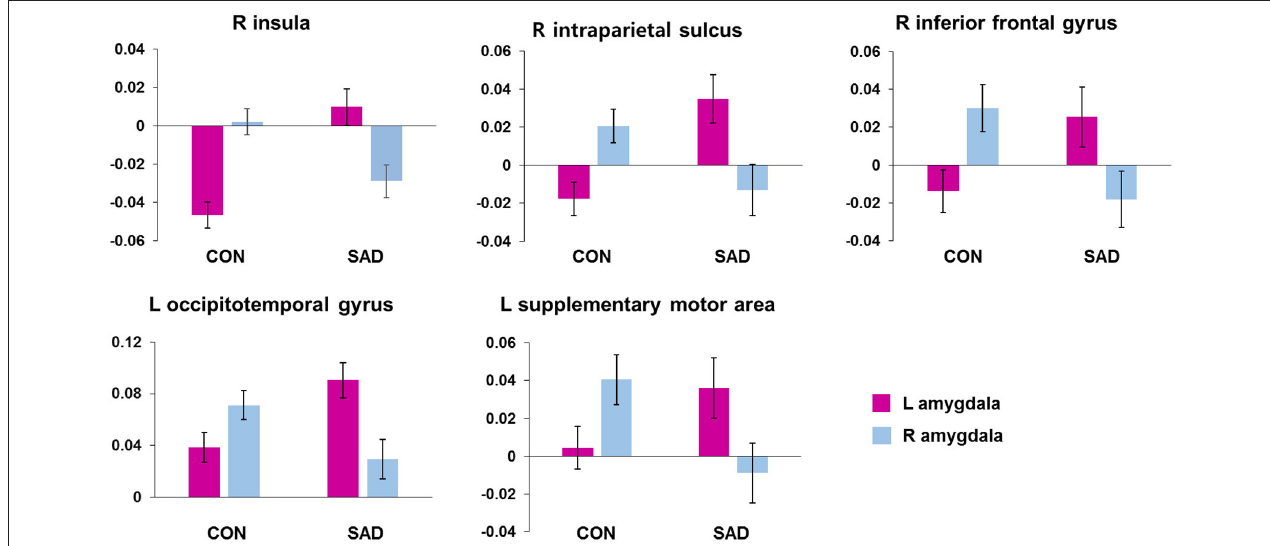
FIGURE 1 | Brain regions showing between-group differences in hemispheric asymmetry in the resting-state functional connectivity of the left and right amygdala. The bar indicates mean ± standard error of z -scores of the functional connectivity in each cluster with the Left or Right amygdala. CON, healthy controls; SAD, social anxiety disorder; L, left; R, right.